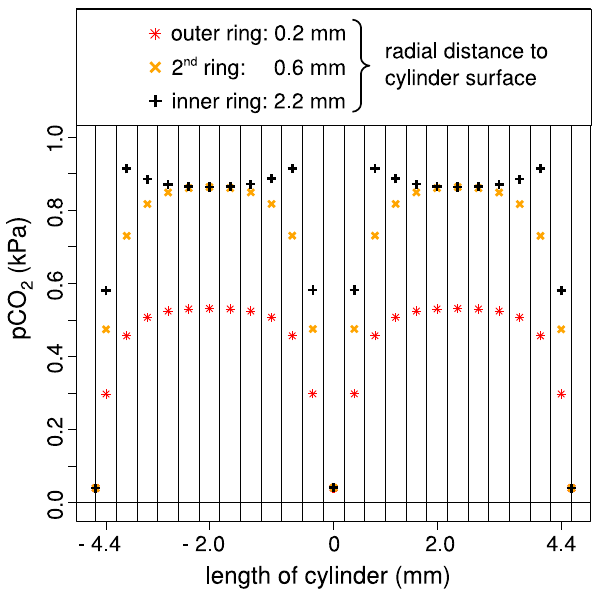
Fig. 5. Modelled CO 2 partial pressures in a siliceous, aerobic soil aggregate (system b) at the soil surface. The vertical lines mark the boundaries of the cylinder slices. The pore-space of the middle slice is air-filled, the other slices are water-saturated (geometry and respiration as in Fig. 3). The pH values are controlled by the carbonic acid (Fig. 6).